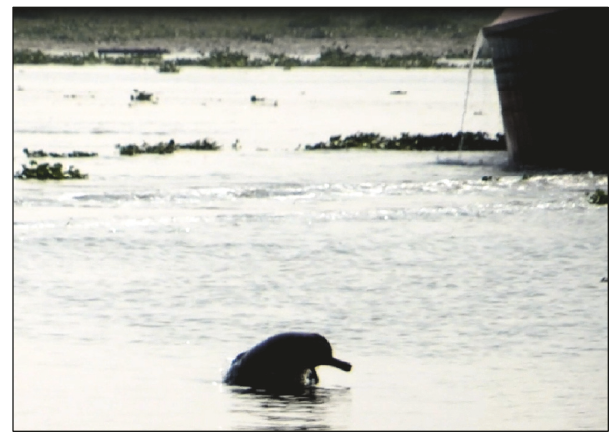
Figure 4: Transport vessels moved on feeding zone of river dolphin in the Turag River.